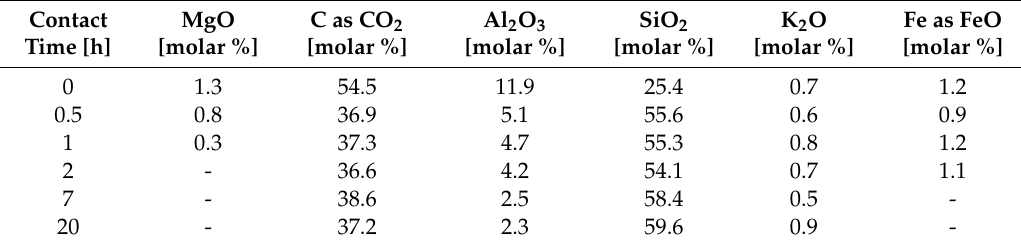
Table 2. Mineralogical characteristics of clays at several contacting times with HCl 3 N (EDS).